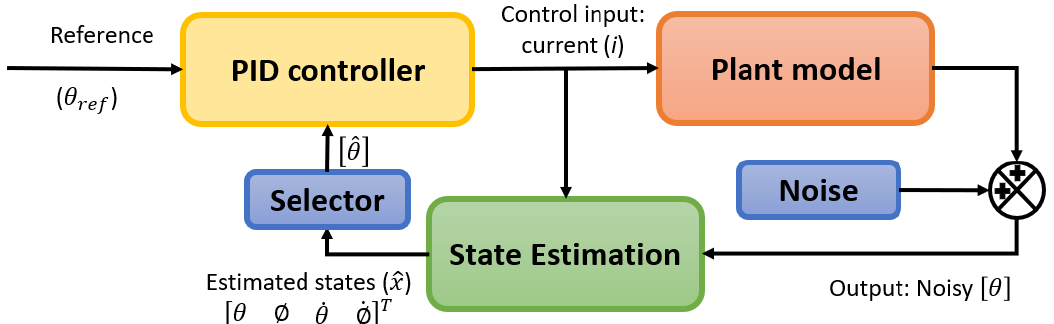
Figure 6. Basic process flow for 2DSFL and 2DSFJ, where θ : angular position, φ : angular shift, ˙ θ : angular velocity, ˙ φ : rate of angular